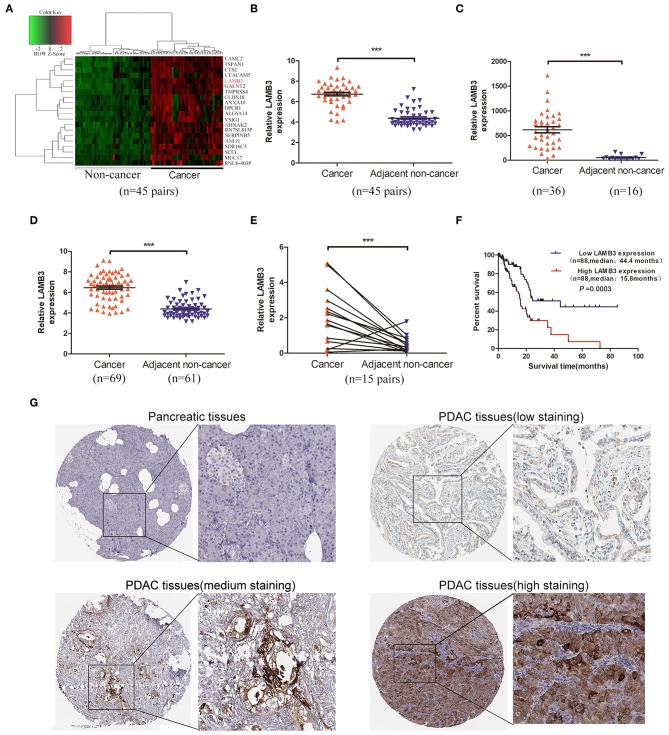
LAMB3 is upregulated in PDAC tissues and is associated with PDAC prognosis. (A) The cluster heat map showed that LAMB3 was overexpressed in PDAC tissues. (B) GEO GSE28375 dataset, (C) GSE16515 dataset, and (D) GSE62452 dataset confirmed that LAMB3 was overexpressed in PDAC tissues. (E) Higher expression levels of LAMB3 were detected using qRT-PCR in 15 matched PDAC tissues. Data are presented as mean ± SD; paired or unpaired t-test; ***p < 0.001. (F) Kaplan-Meier analysis revealed that LAMB3 overexpression was associated with poorer overall survival of PDAC patients. p < 0.001, log-rank test. (G) IHC (immunohistochemistry) results from the Human Protein Atlas demonstrated that LAMB3 was upregulated in PDAC tissues.